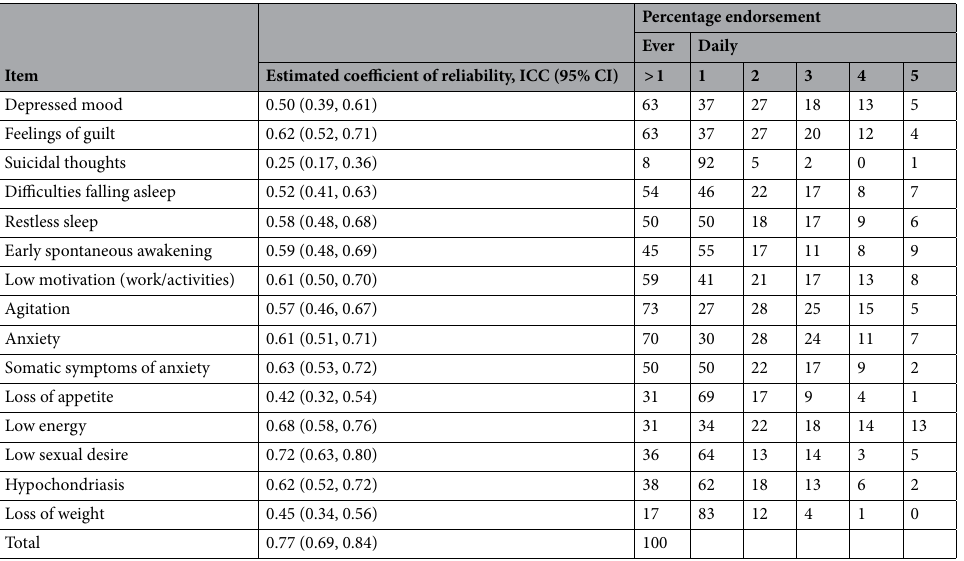
Table 4. Descriptive statistics for endorsement of daily manifestations of MDD symptoms based on HRSD-DS. Person-level N = 50; daily-level N = 952; ICC = intraclass correlation; CI = confidence interval.